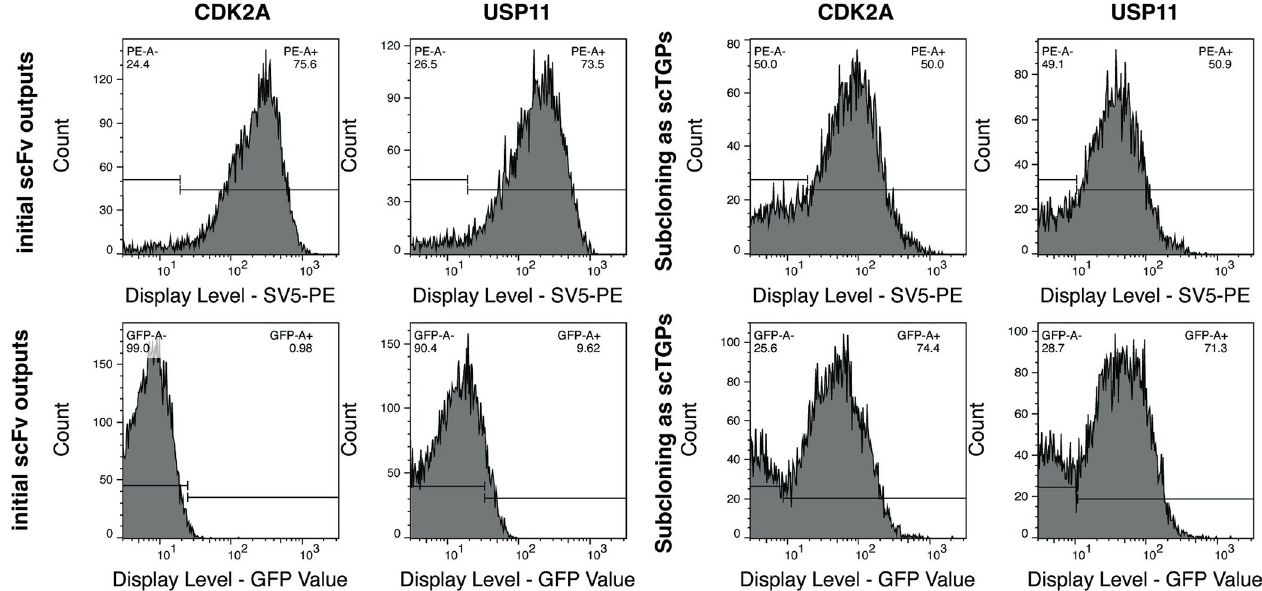
Fig 3. Comparison of yeast display levels for the parent scFv library and the scTGP library. The display levels shown on the x-axis were assessed with anti- SV5 labeled with PE (YG-PE) or the intrinsic green fluorescence of TGP. The left-hand panel provides data for the scFv library while the right-hand panel provides data for the scTGP libraries. Data for CDKA2A and USP11 libraries are